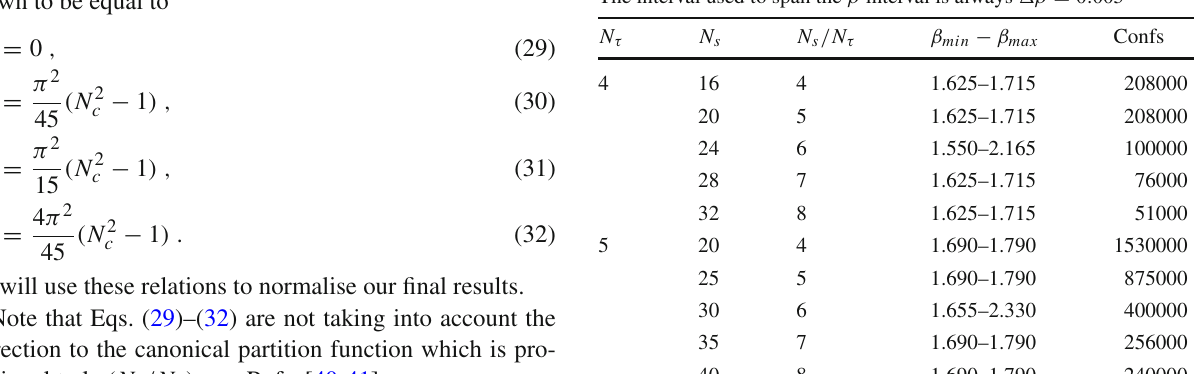
Table 6 Summary of the simulations employed at finite temperature. The interval used to span the β interval is always (cid:13)β = 0 . 005